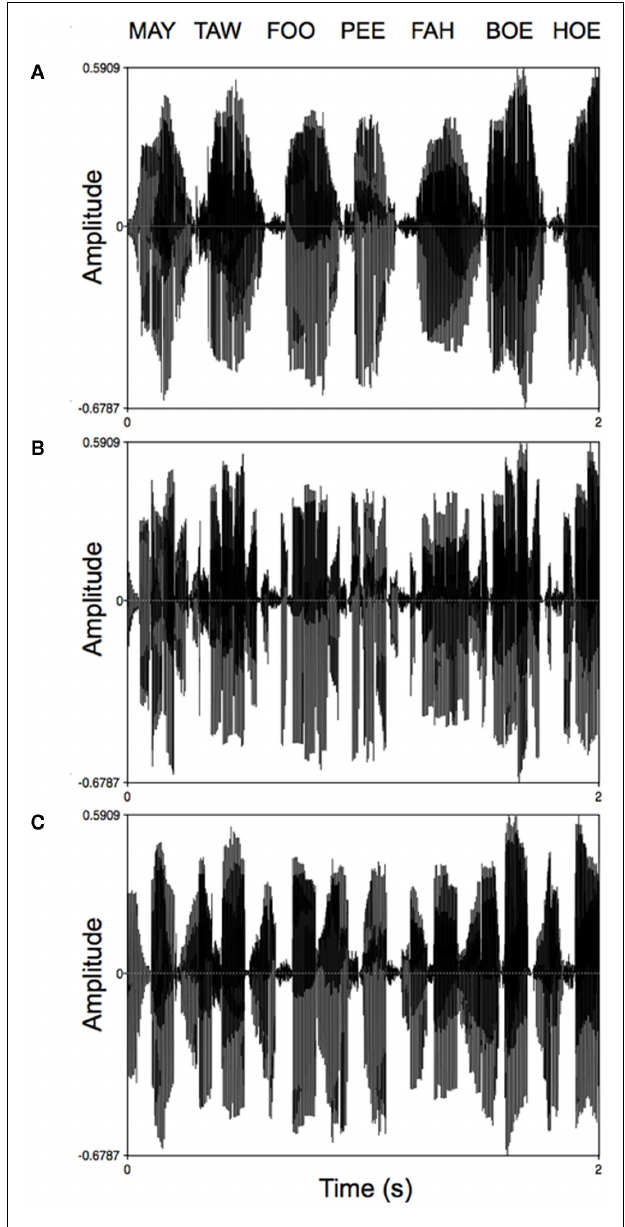
FIGURE 1 |A 2-s excerpt from (A) normal, (B) 50-ms time-reversed, and (C) 100-ms time-reversed familiarization